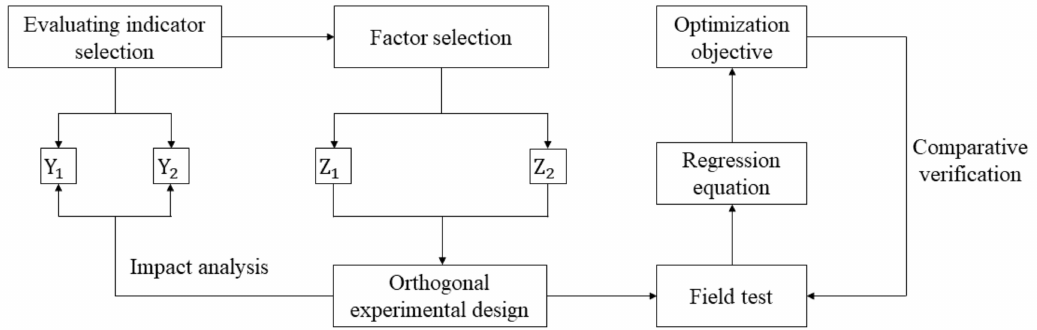
Figure 9. Materials and methods flow